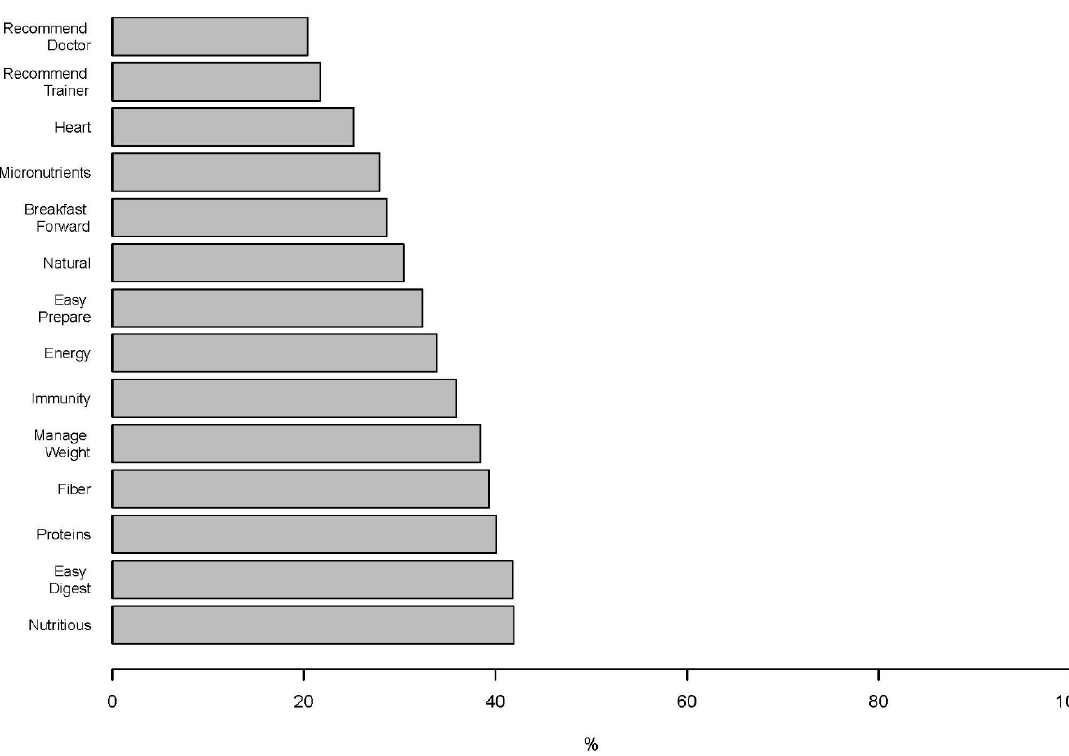
Figure 3. Top factors reported by percentage of participants contributing to oat consumption during the COVID ‐ 19 con ‐ finement.